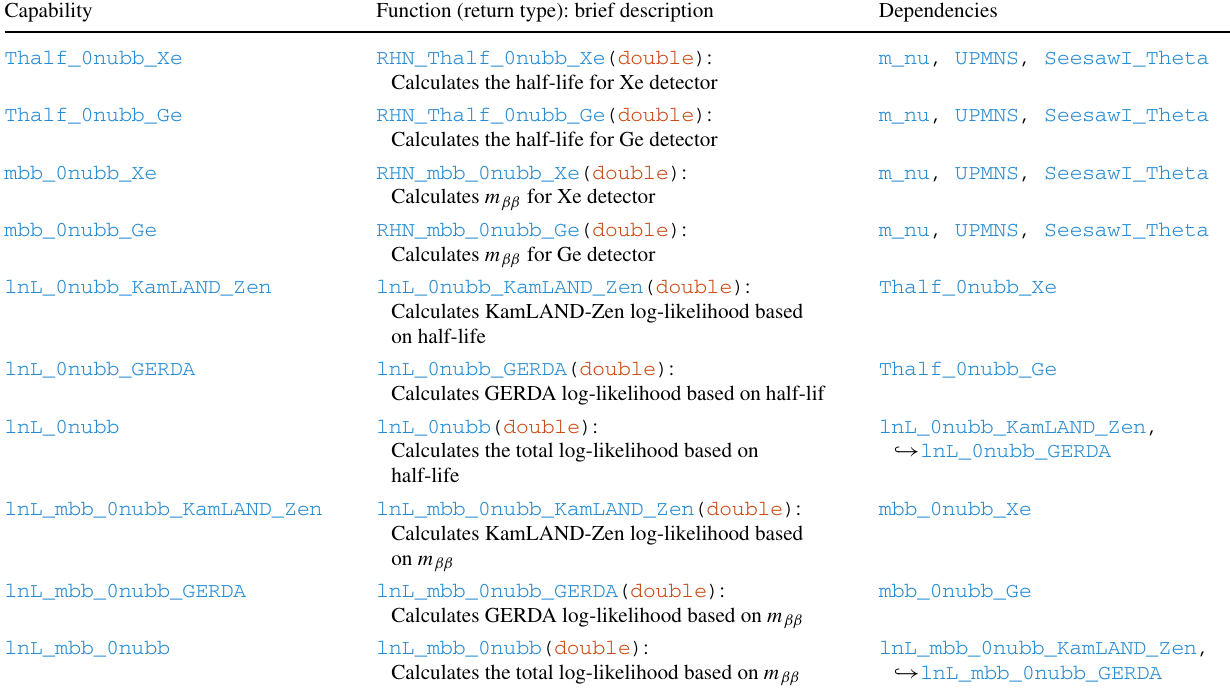
Table 16 Capabilities and module functions implemented to calculate neutrinoless double-beta decay observables and likelihood